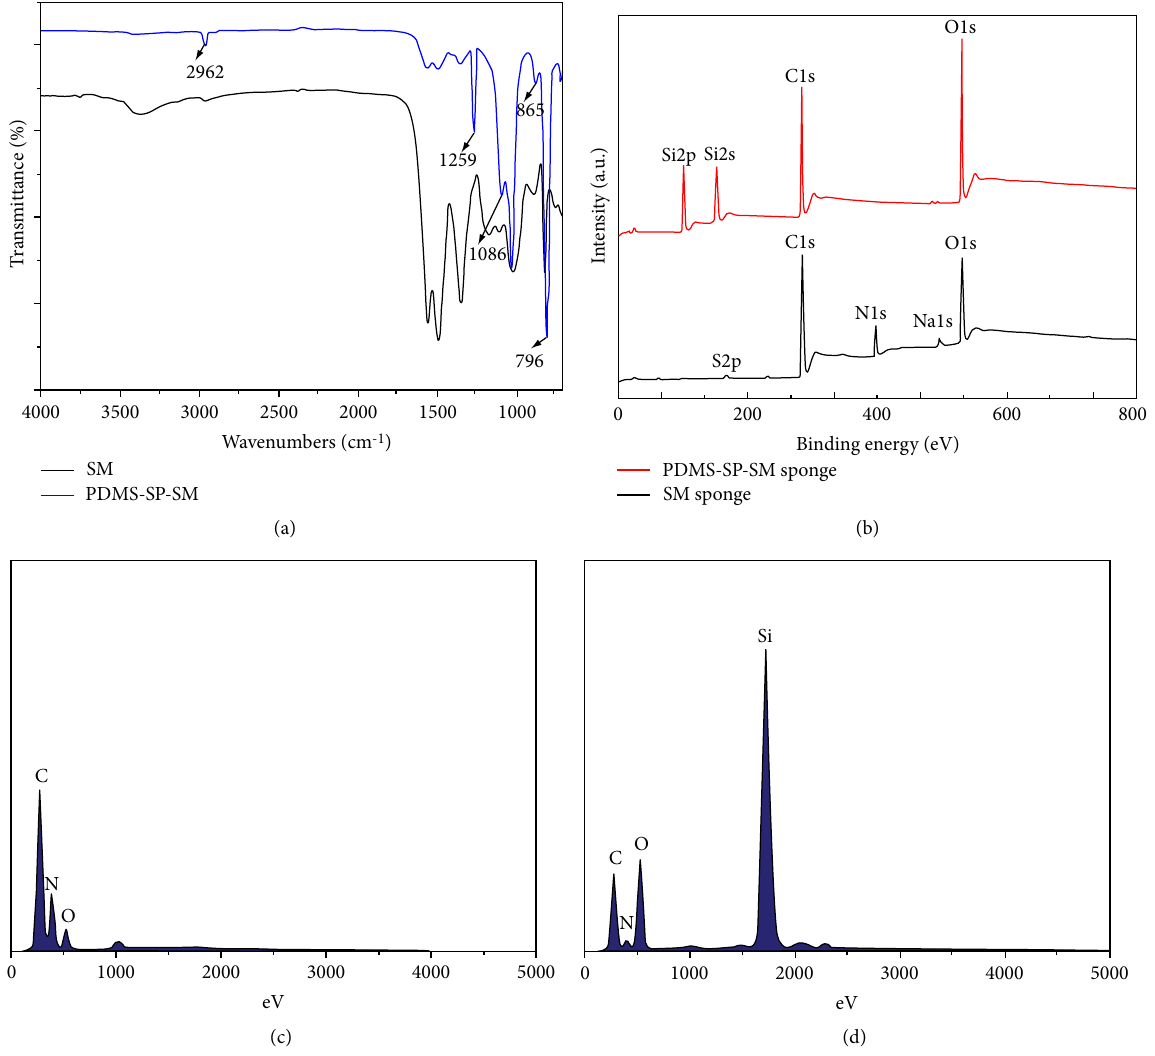
Figure 2: (a) ATR-FTIR spectra of pristine melamine sponge and PDMS-SP modified melamine sponge, (b) XPS spectra of pristine melamine sponge and PDMS-SP modified melamine sponge, (c) EDS spectra of pristine melamine sponge on the sponge framework surface, (d) EDS spectra of PDMS-SP modified melamine